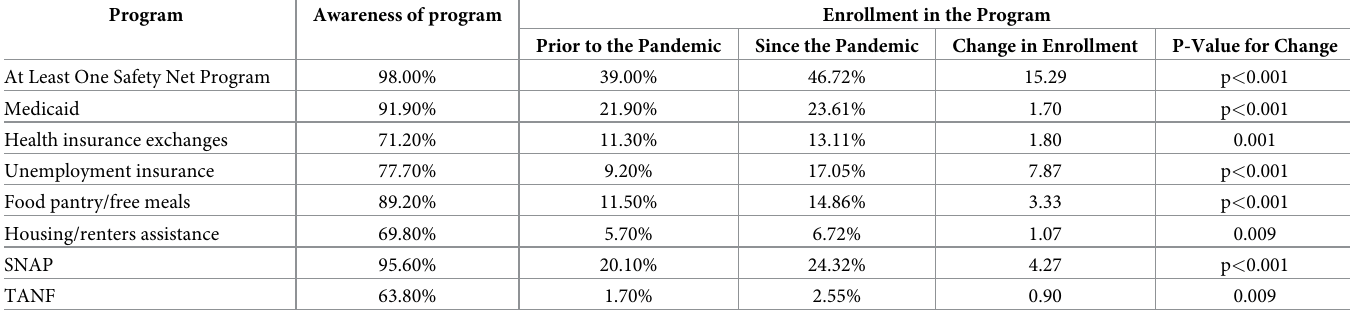
Table 3. Awareness and enrollment in safety net programs before and since pandemic.